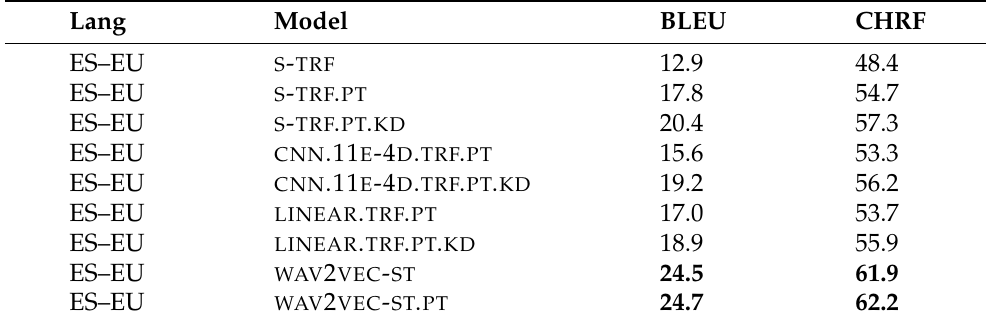
Table 11. Comparative results for end-to-end model variants on Spanish to Basque translation. The best results, indicated in bold, were statistically significant against all other results, for p < 0.05; differences between top-performing systems in bold were not statistically